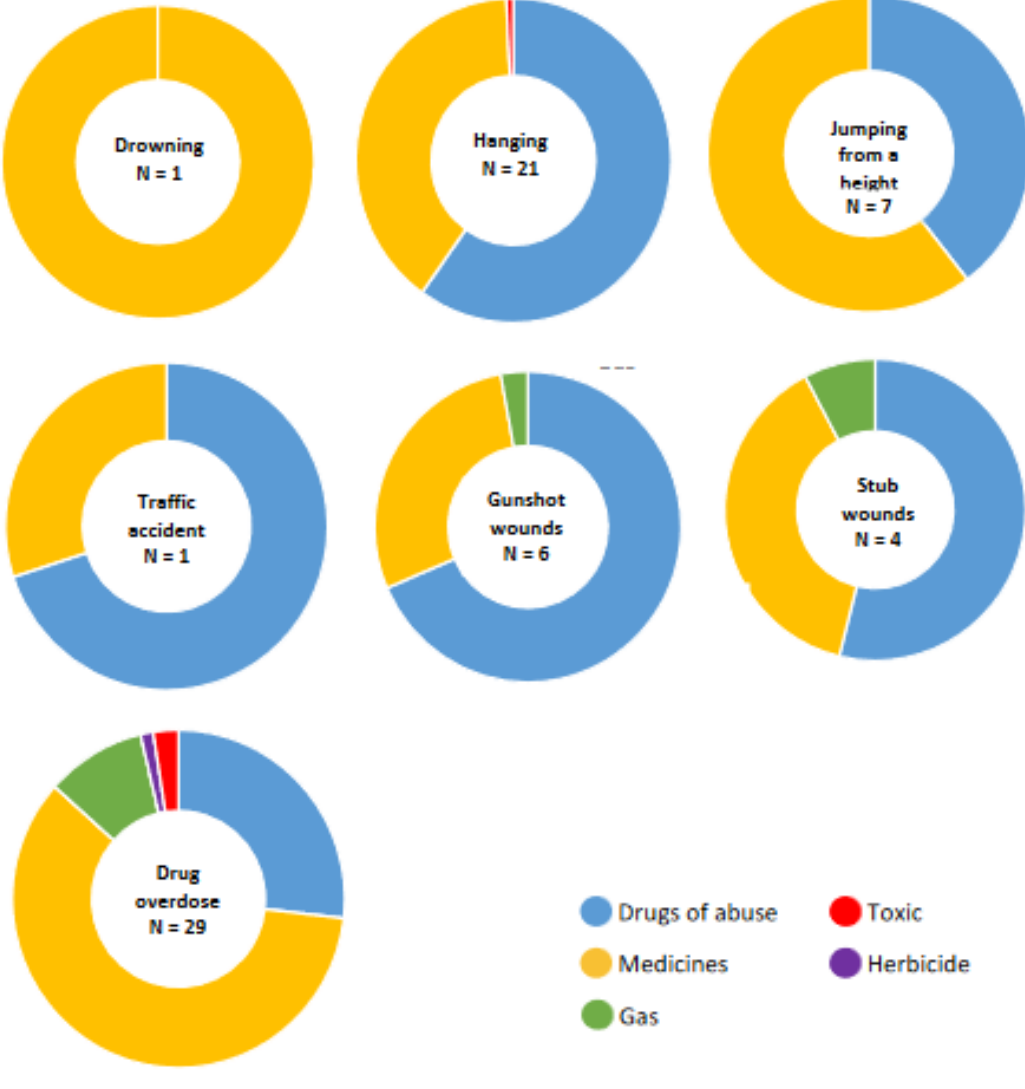
Figure 4. Suicide mechanisms.